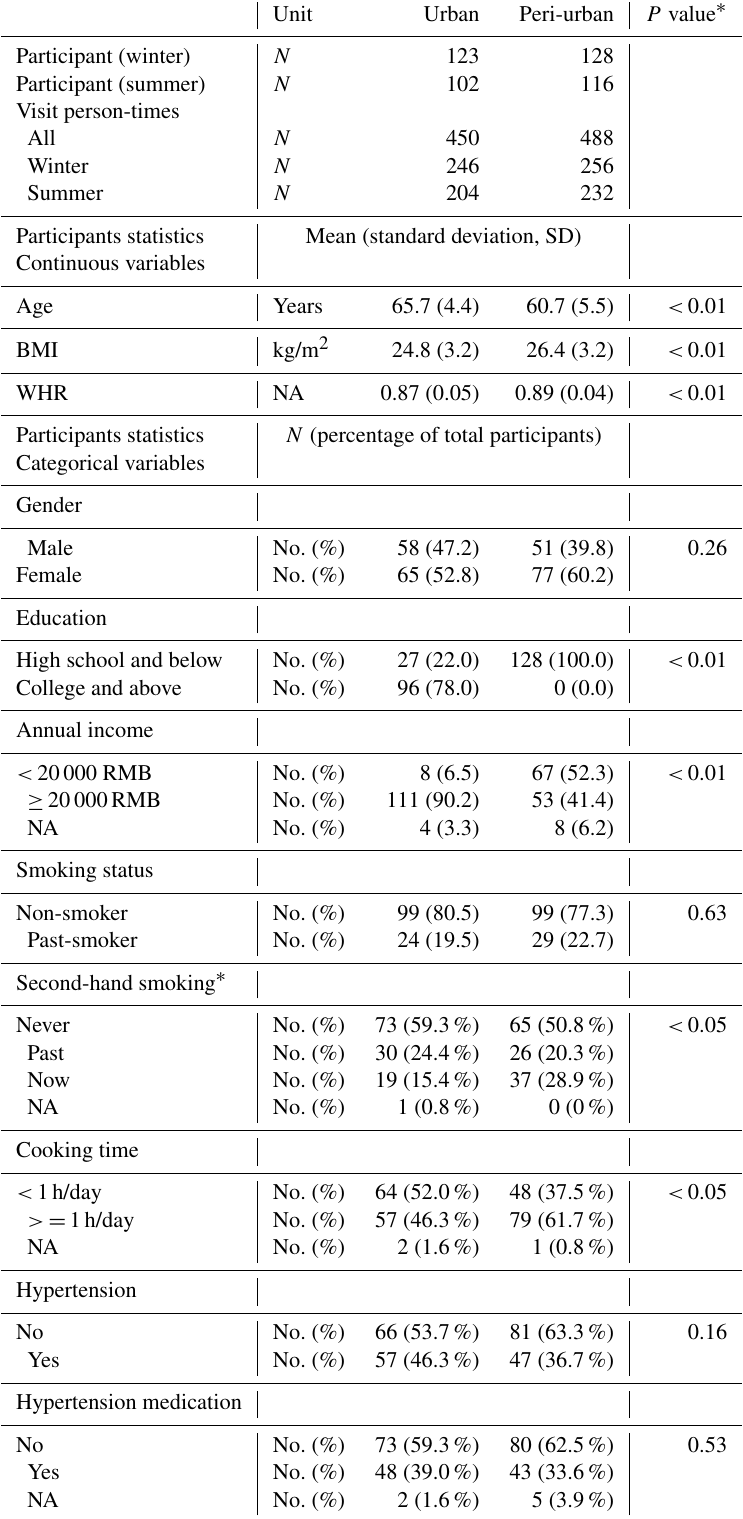
Table 4. Statistic summary of demographic characteristics of urban and peri-urban